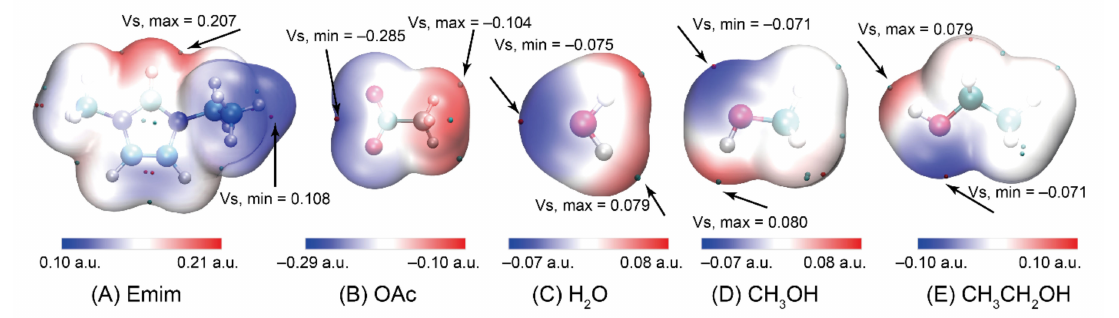
Figure 2. The electrostatic potential on the van der Waals surfaces of ( A ) Emim, ( B ) OAc, ( C ) H 2 O, ( D ) CH 3 OH, and ( E ) CH 3 CH 2